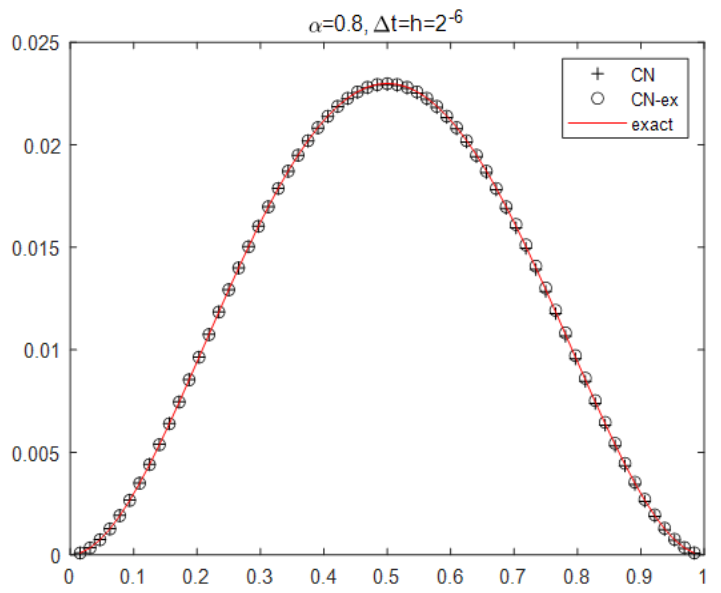
Figure 8. The numerical solution for the Crank-Nicolson scheme and the extrapolated Crank-Nicolson scheme and exact solution for Example 2 with α = 0.8, ∆ t = h = 2 − 6 at time T =